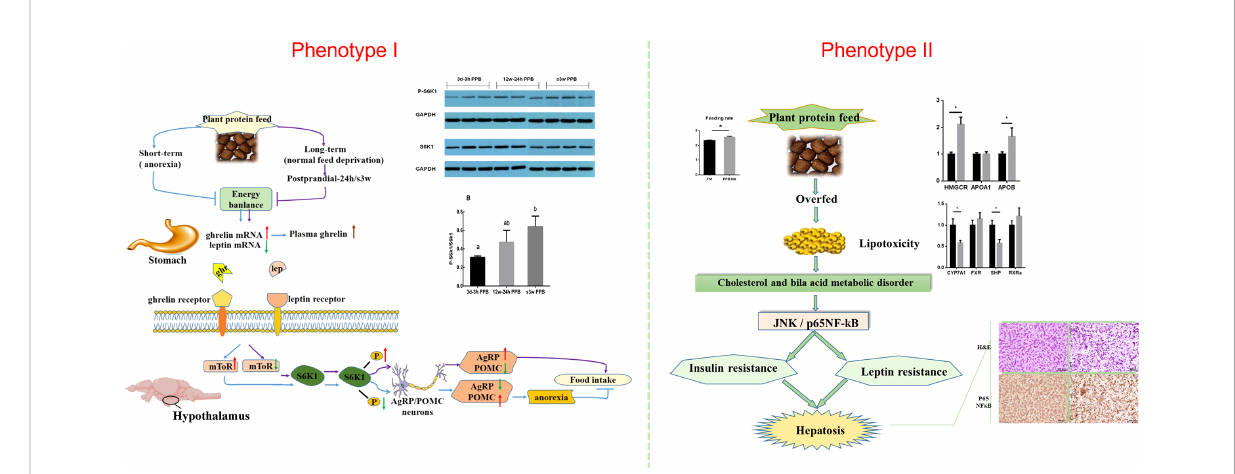
FIGURE 4 Two phenotypes of Japanese seabass when fi shmeal is replaced by plant protein. Phenotype one causes obvious feeding inhibition, signi fi cantly reduced growth performance and high mortality rates. Phenotype two is normal feeding and survival, but the fi sh gradually experience protein, glucose, and lipid metabolism disorders, followed by chronic in fl ammation, hepatocyte apoptosis, and liver